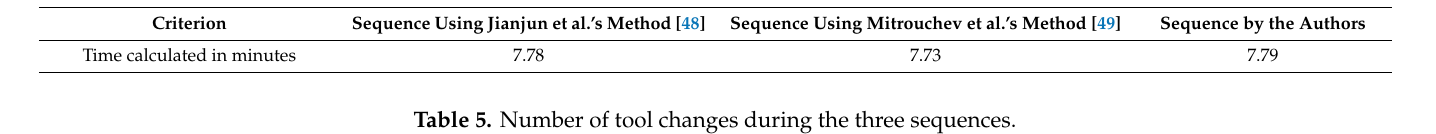
Table 4. The evaluation of spending of time through the three sequences.